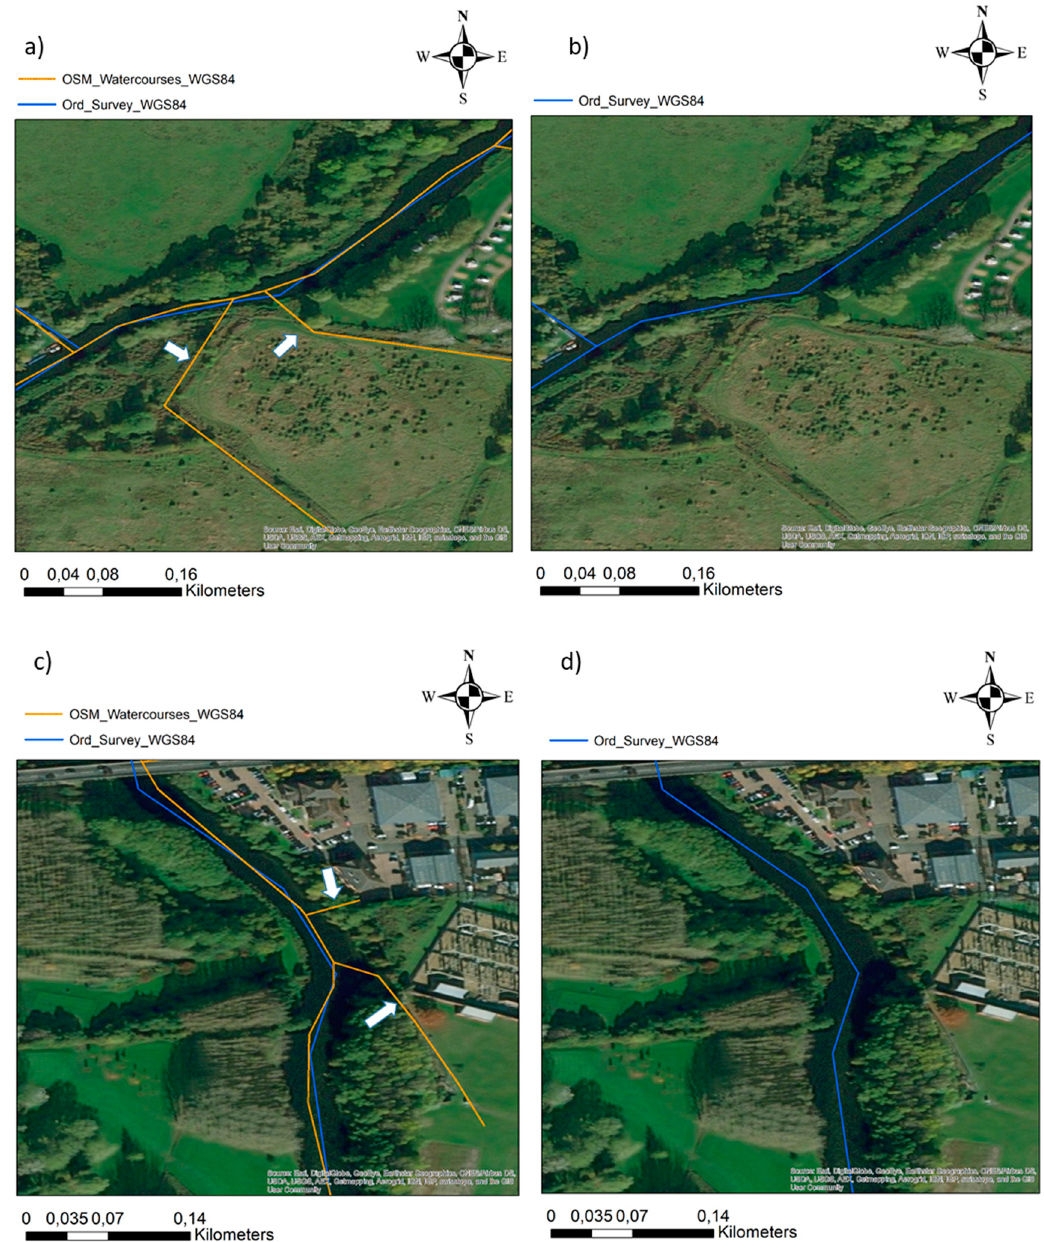
Figure 7. ( a , c ) show OSM watercourses that were removed from the drainage network used to create the rebuilt DEM (highlighted with white arrows); and ( b , d ) show the image without the OSM watercourses.